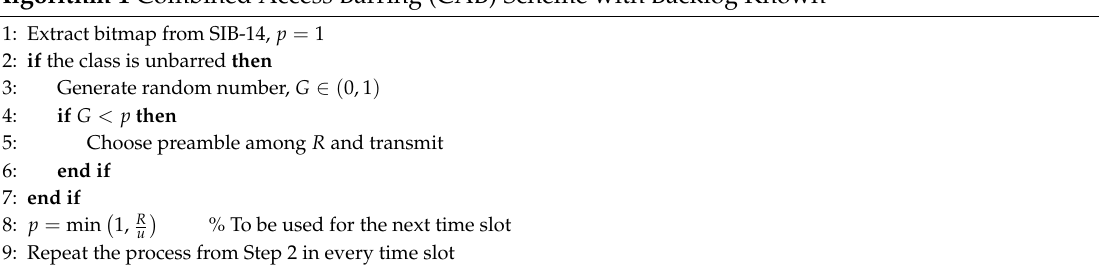
Algorithm 1 Combined Access Barring (CAB) Scheme with Backlog